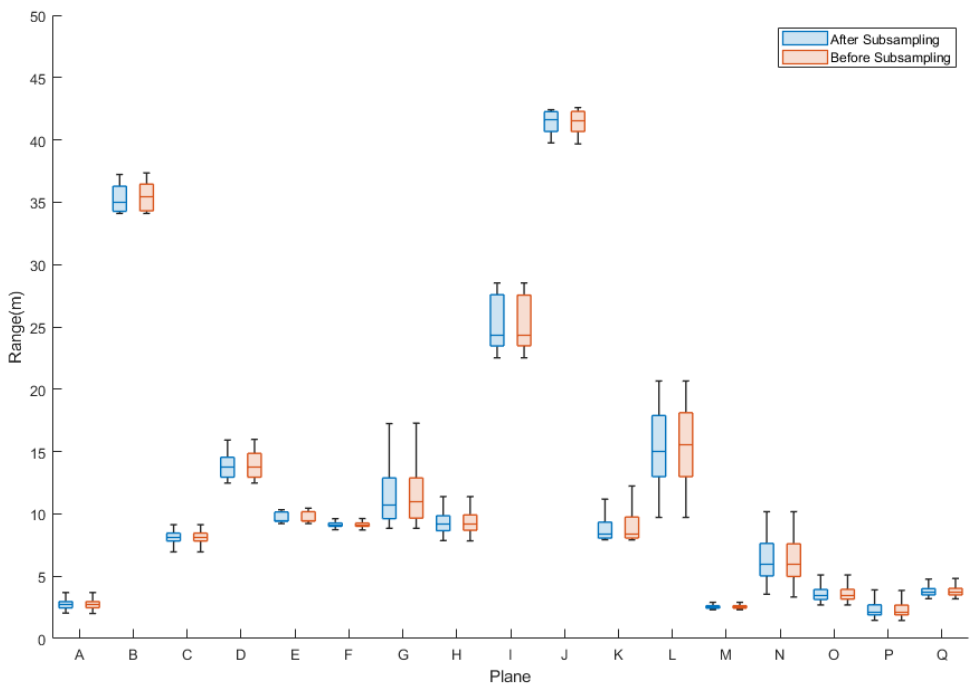
Figure 15. Box diagram of the calculated pseudoranging measurements of each plane, before and after subsampling and blunder removal by the RANSAC algorithm for dataset DATA1.